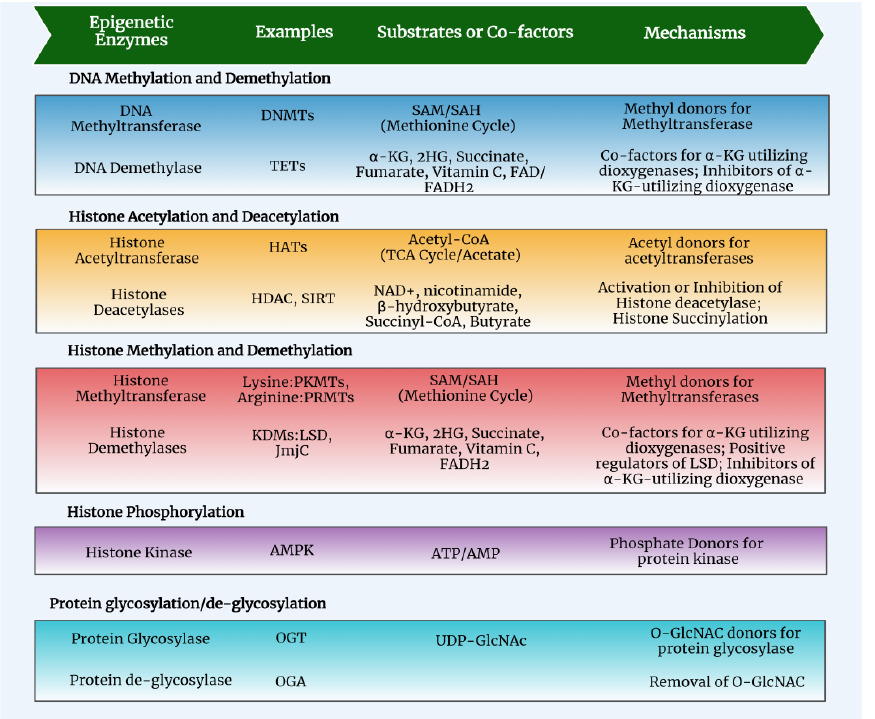
Figure 4. Cellular metabolites used as substrates or cofactors for epigenetic enzymes and their mechanism of action. (Concept taken from [105] and created with BioRender.com. Last accessed 22 January 2023). Biology 2023 , 12 , x